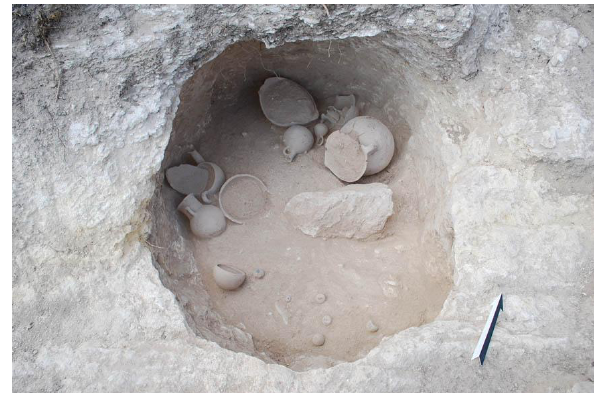
Figure 1. The workshop area Figure 2. The tomb 231 with its offering